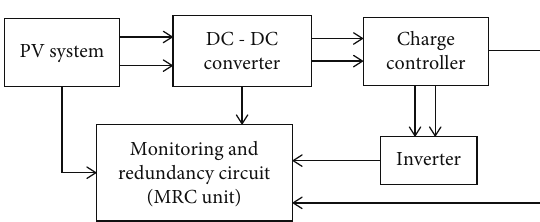
Figure 7: Bypass diode fault.